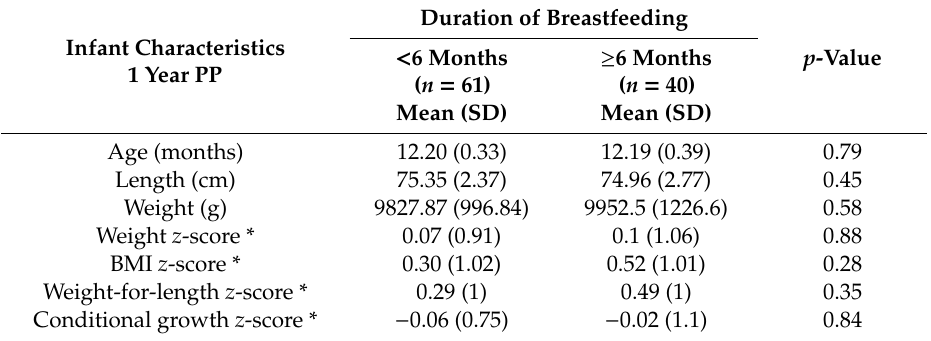
Table 3. Characteristics of the infants based on duration of breastfeeding ( n = 101).